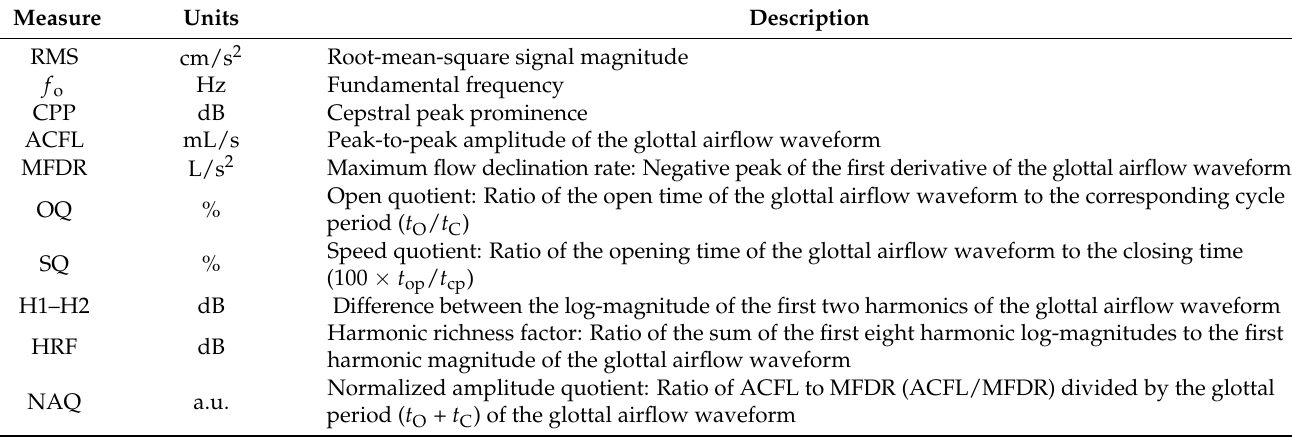
Table 2. Accelerometer-based vocal function measures input into Ps Estimation Methods 3 and 4. See Figure 3 for an illustration of the waveform and spectra parameterization.